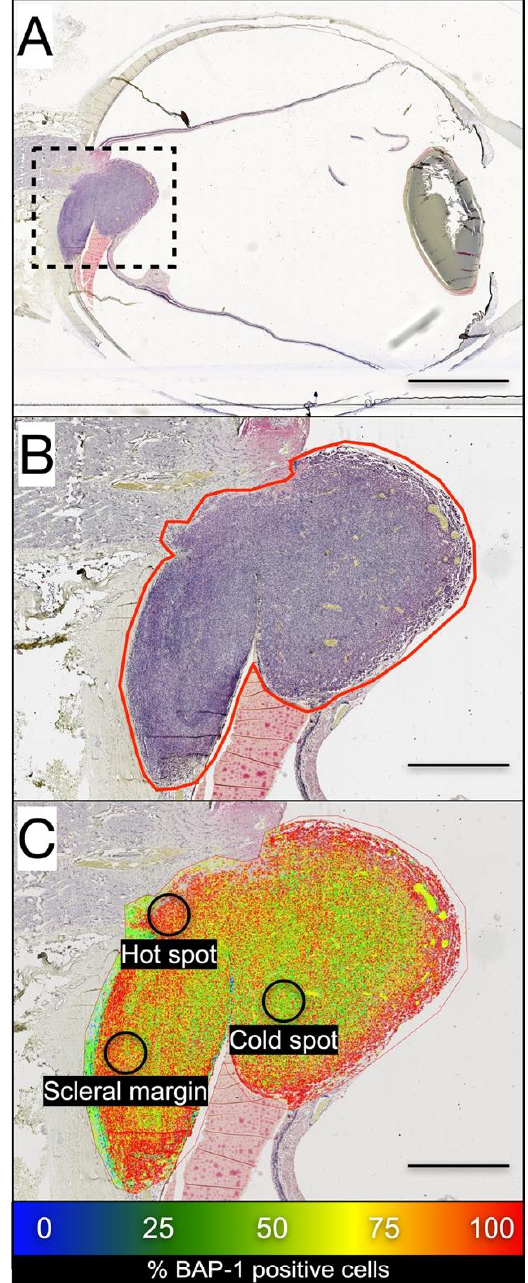
Figure 2. BAP-1 expression heat map by digital image analysis. ( A ) A choroidal melanoma growing on top of the optic nerve head is outlined. ( B ) A region of interest is drawn around the edges of the tumor. In this region, digital image analysis identified BAP-1 positive and negative cells. ( C ) Tumor regions with relatively high (red), intermediate (green) and low (blue) proportions of BAP-1 positive cells can be visualized. The hot spot was defined as the circular region with a diameter of 0.5 mm (corresponding to an area of 0.2 mm 2 per tumor, or one high-power field in a light microscope at 400 × ) with the highest proportion of BAP-1 positive tumor cells in any part of the tumor. The cold spot was defined as the circular region with a diameter of 0.5 mm with the lowest proportion of BAP-1 positive tumor cells in any part of the tumor. Scleral margin was defined as the circular region with a diameter of 0.5 mm with the lowest proportion of BAP-1 positive tumor cells within 1 mm from the tumor base towards the sclera. Scale bars: ( A ), 5 mm; ( B , C ): 1